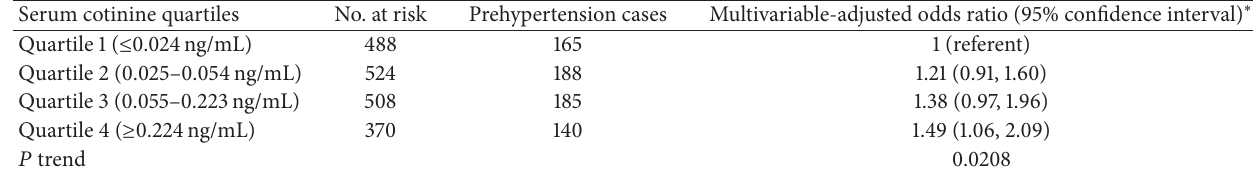
Table 6: Association between serum cotinine levels and prehypertension among those with serum cotinine < 10ng/mL. Serum cotinine quartiles No. at